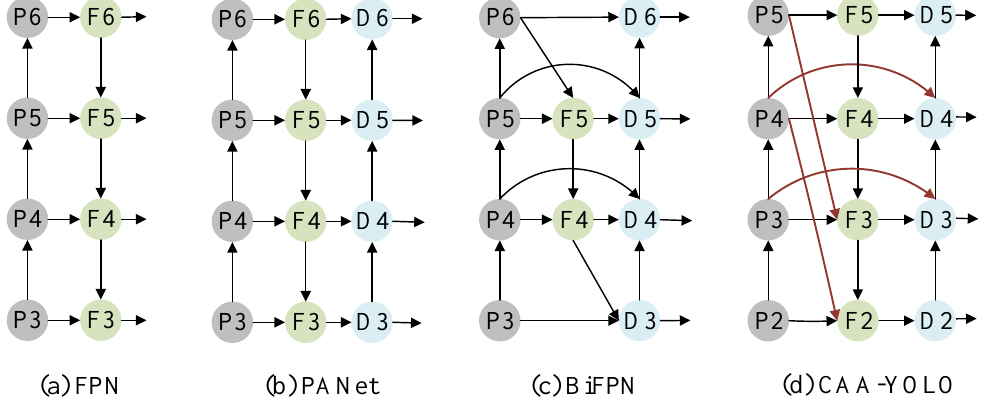
Figure 6. Feature network design: ( a ) FPN introduces a top-down pathway to fuse multiscale features from level 3 to 6 (P3–P6); ( b ) PANet adds an additional bottom-up pathway on top of FPN; ( c ) BiFPN with cross-scale connections ( d ) is our CAA-YOLO with more context